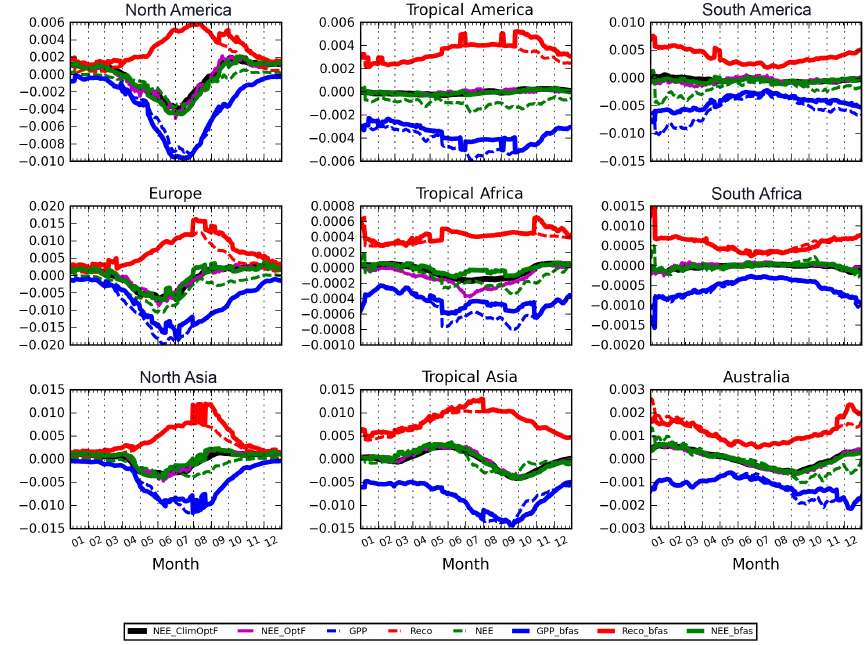
Figure 7. Time series of GPP (in blue), R eco (in red) and NEE (in green) daily budget (GtCday − 1 ) before and after the flux adjustment (see dashed lines and solid lines, respectively) for crops in 2010 in the different regions. The reference budget provided by the climatology of MACC-13R1 optimized fluxes (2004–2013) and the MACC-13R1 optimized fluxes for 2010 are depicted by the black and magenta lines, respectively. Positive/negative values correspond to a source/sink of CO 2 . Table 3. List of TCCON stations used in Fig. 10 ordered by latitude from north to south. Site Latitude Longitude Altitude Reference (degrees) (degrees) (ma.s.l.) Sodankylä 67.37 26.63 190.0 Kivi et al. (2014) Białystok 53.23 23.02 160.0 Deutscher et al. (2014) Lamont 36.60 − 97.49 320.0 Wennberg et al. (2014) Wollongong − 34.41 150.88 30.0 Griffith et al.